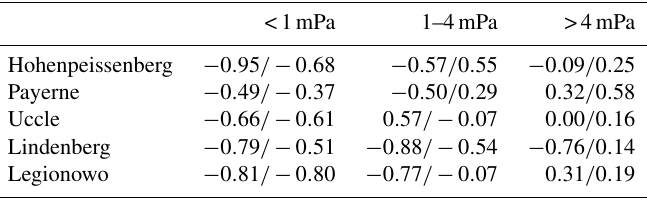
Table 2. Correlation coefficient of lamina number and average vertical resolution at the European middle-latitude stations from the period 1970–2016 (before slash – PL; after slash – GL). Significant correlation coefficient values are in bold.